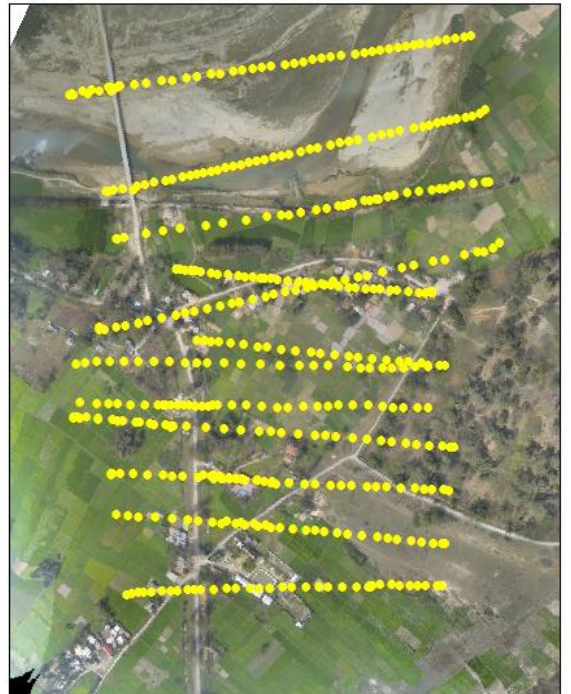
Figure 2. Actual flight (its plan was presented in Figure